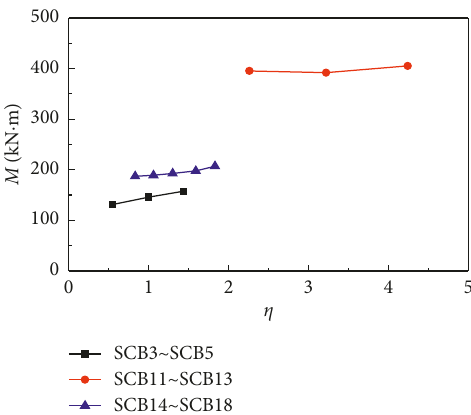
Figure 6: Relationship between M and ρ